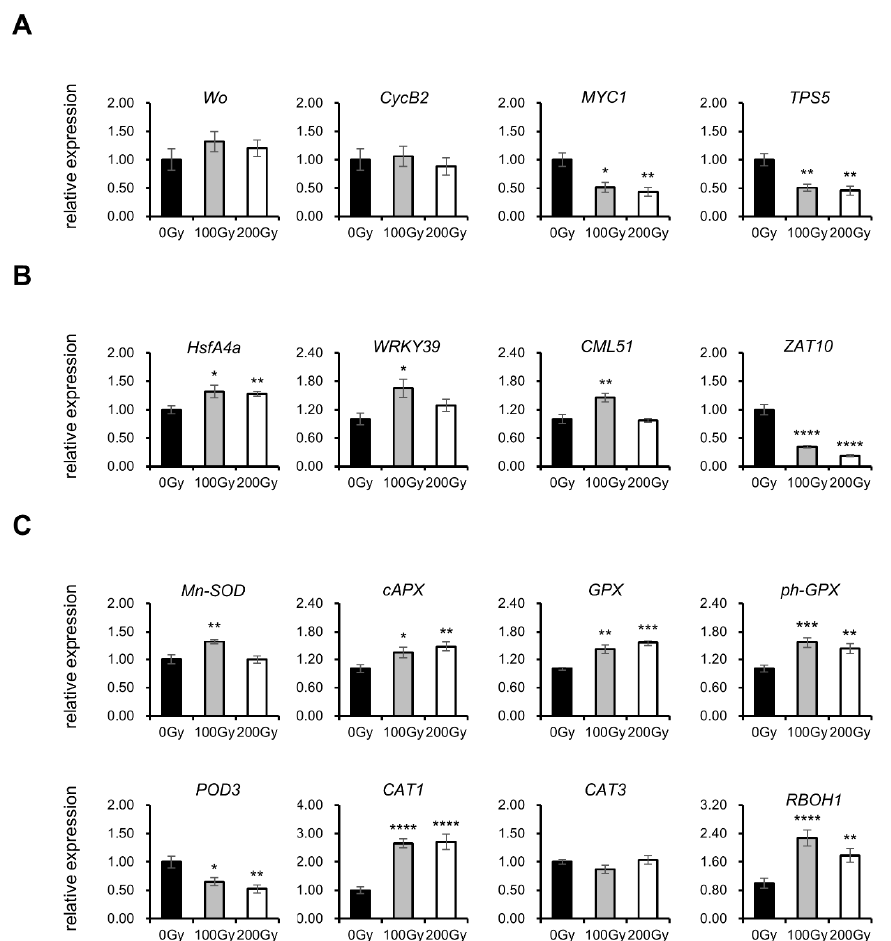
Figure 2. Expression levels of genes involved in trichome development, reactive oxygen species (ROS) signaling, and scavenging in leaves of gamma-irradiated M 1 plants. Control (0 Gy) plants and gamma-irradiated plants (100 and 200 Gy) were used. Gene expression levels were analyzed via quantitative real-time polymerase chain reaction (qRT-PCR) and the values were normalized to the levels in control plants. Data are presented as mean ± SE of four biological replicates. Asterisks represent significant differences between control and gamma-irradiated plants (unpaired t -test: * p < 0.05; ** p < 0.01; *** p < 0.001; **** p < 0.0001). ( A ) Genes involved in trichome development. ( B ) Genes related to reactive oxygen species (ROS) signaling. ( C ) Genes involved in ROS scavenging.